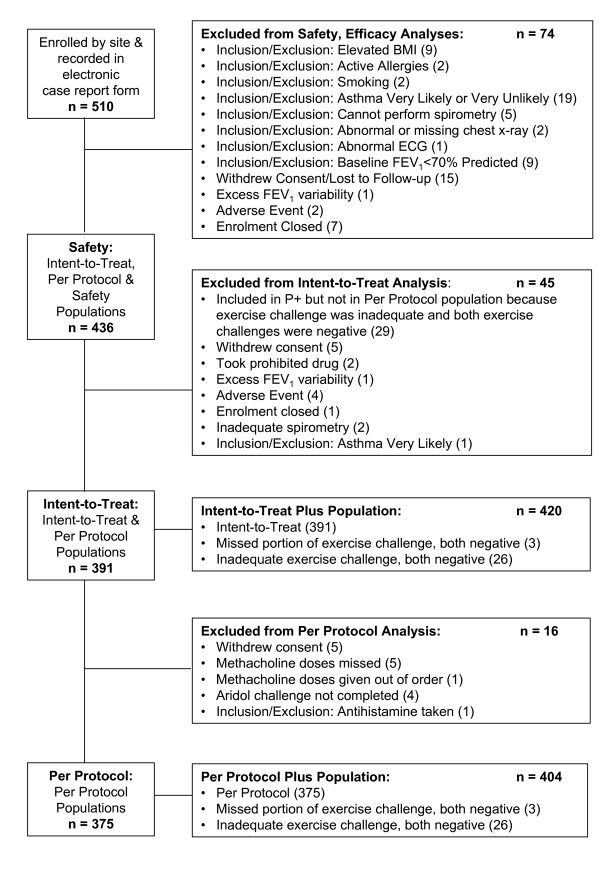
Subject disposition.